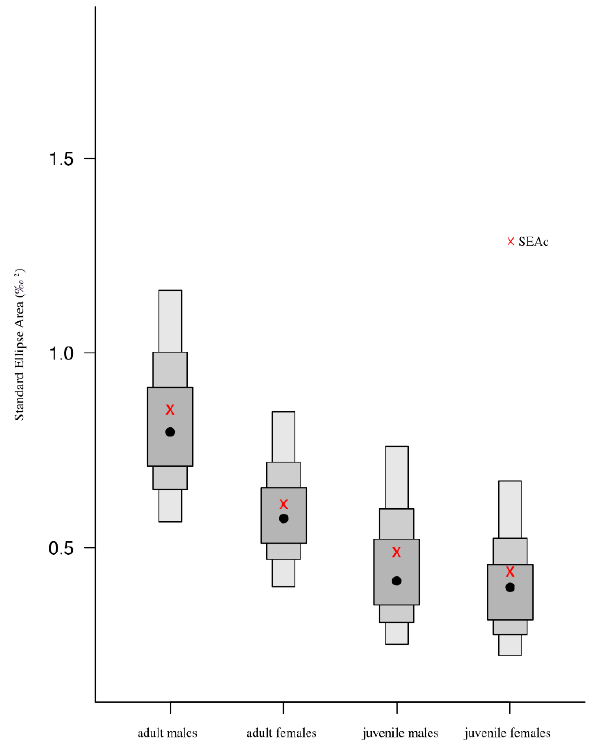
Figure 5. Bayesian density plots showing the credibility intervals (50%, 75%, and 95%) of the standard ellipse areas for the southern king crab Lithodes santolla groups estimated by SIBER analysis. Black points = mean standard ellipse area, red points = mean standard ellipse areas corrected for small sample size (SEA c ).